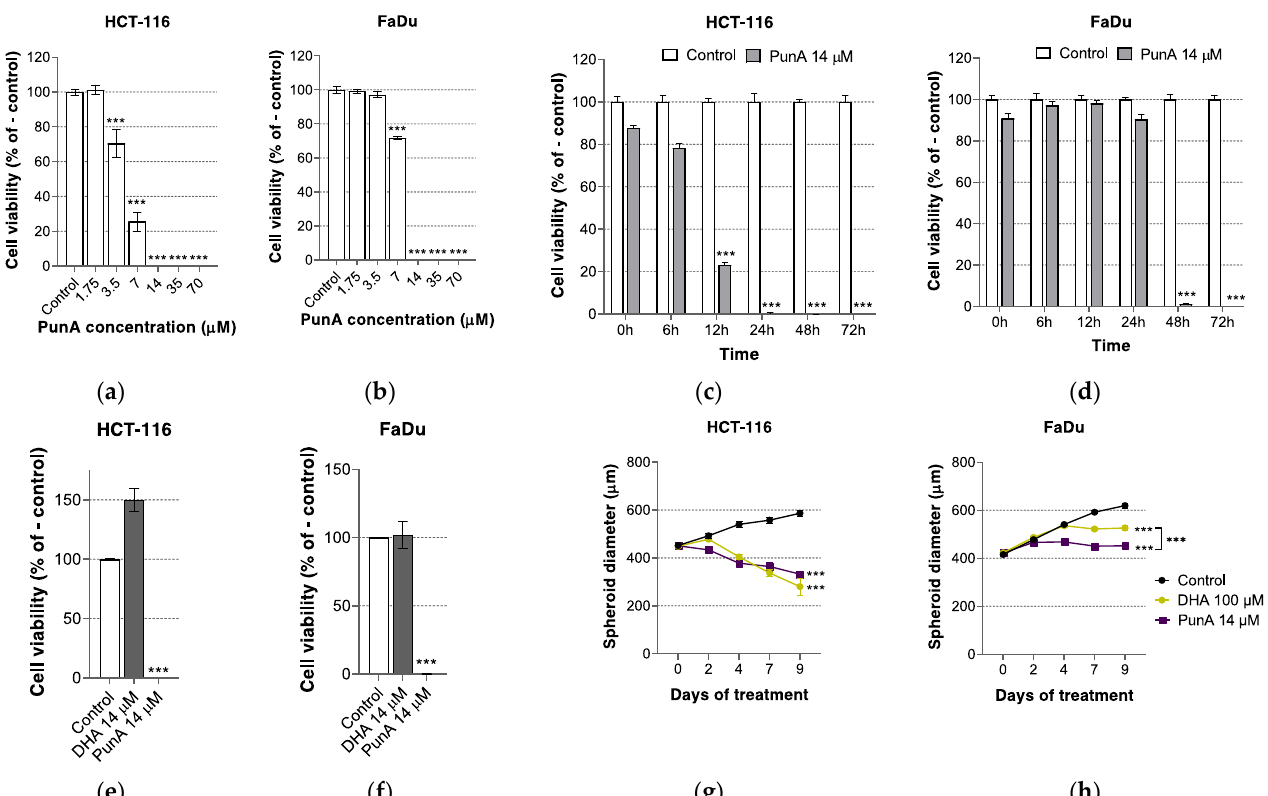
Figure 1. Punicic acid (PunA) decreases the viability of HCT-116 and FaDu carcinoma cells and its effect arises from a lower dose as compared to docosahexaenoic acid (DHA). ( a ) Cytotoxic effect of increasing concentrations of PunA on HCT-116 and ( b ) FaDu carcinoma cells after 72 h; ( c ) Kinetics of the cytotoxicity of PunA 14 µM over 72 h on HCT-116 and ( d ) FaDu carcinoma cells; ( e ) Comparison of the cytotoxicity of PunA and DHA at 14 µM on HCT-116 and ( f ) FaDu carcinoma cells applied during 72 h; ( g ) Comparison of the diameter growth of HCT-116 or ( h ) FaDu 3D spheroids under PunA 14 µM or DHA 100 µM. Control: cells or spheroids supplemented with DMEM cell culture medium without added fatty acid. Results are expressed as mean ± standard error of the mean of three independent repetitions. Significance is established in relation to the control ( a , b , e – h ), to PunA 14 µM at 0 h of treatment ( c , d ) or between DHA 100 µM and PunA 14 µM ( g – h ). *** p ≤ 0.0001.